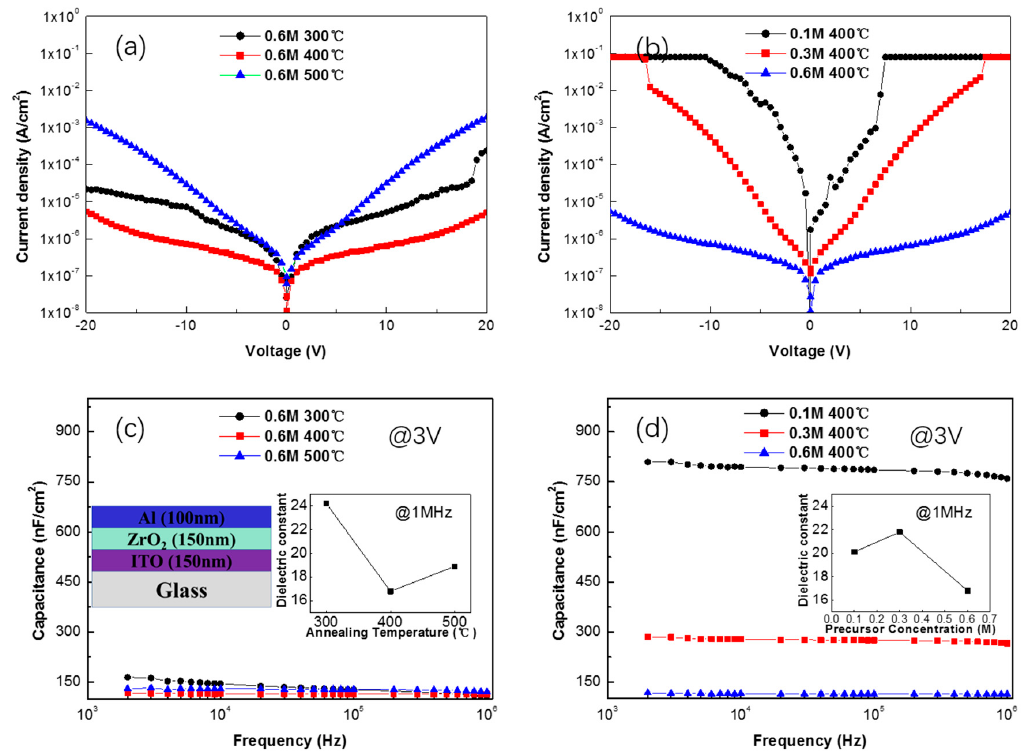
Figure 4. Leakage current vs applied voltage for ( a ) different annealing temperature and ( b ) different concentration precursor-based ZrO 2 film; areal capacitance vs frequency for ( c ) different annealing temperature and ( d ) different concentration precursor-based ZrO 2 film.